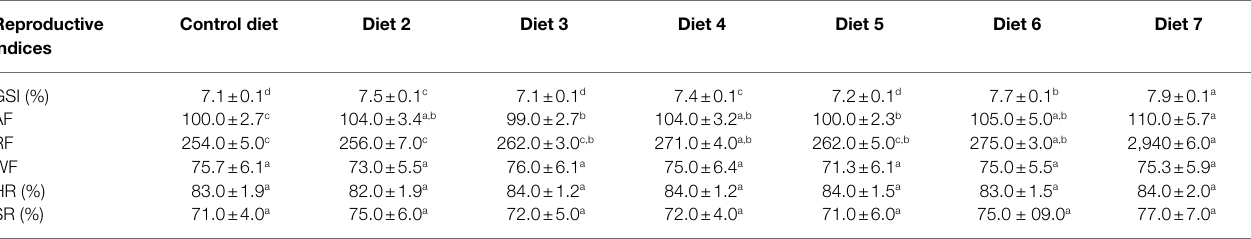
TABLE 4 | Reproduction performance and fry survival of zebrafish fed different experimental diets for 120 days. Reproductive